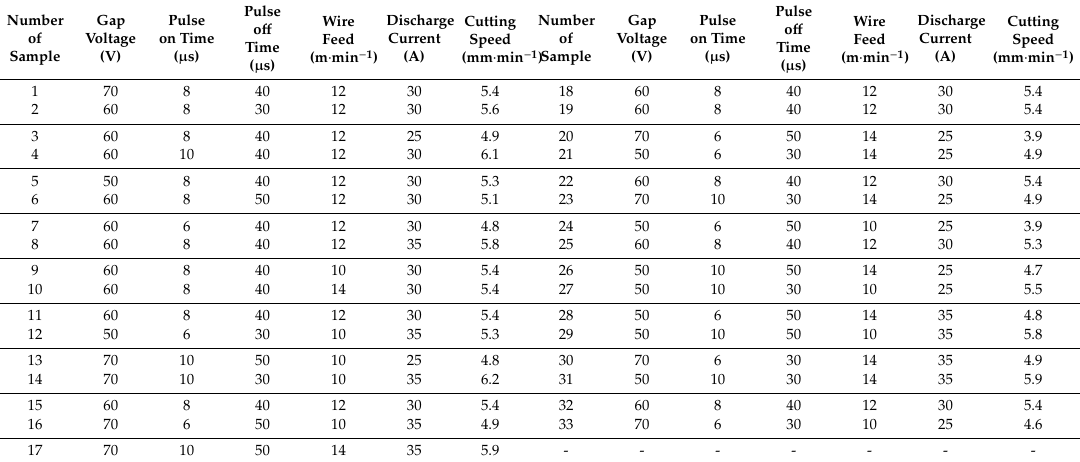
Table 2. Machining parameters used in the experiment and observed cutting speed.